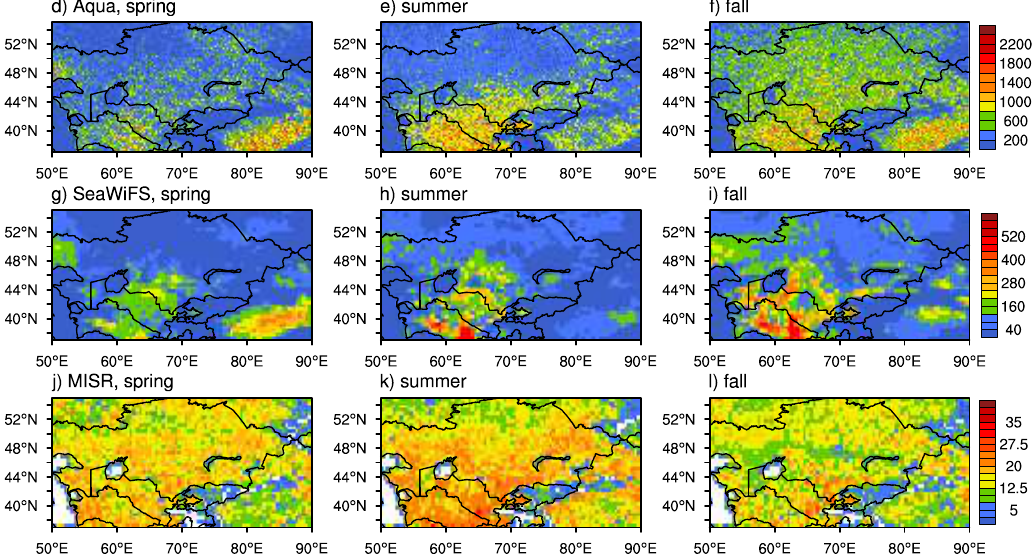
Figure 3. Seasonal mean sampling numbers across Central Asia for MODIS onboard the Aqua satellite ( d , e , and f ), SeaWiFS ( g , h , and i ), and from MISR ( j , k , and l ) during the 2003–2007 period.